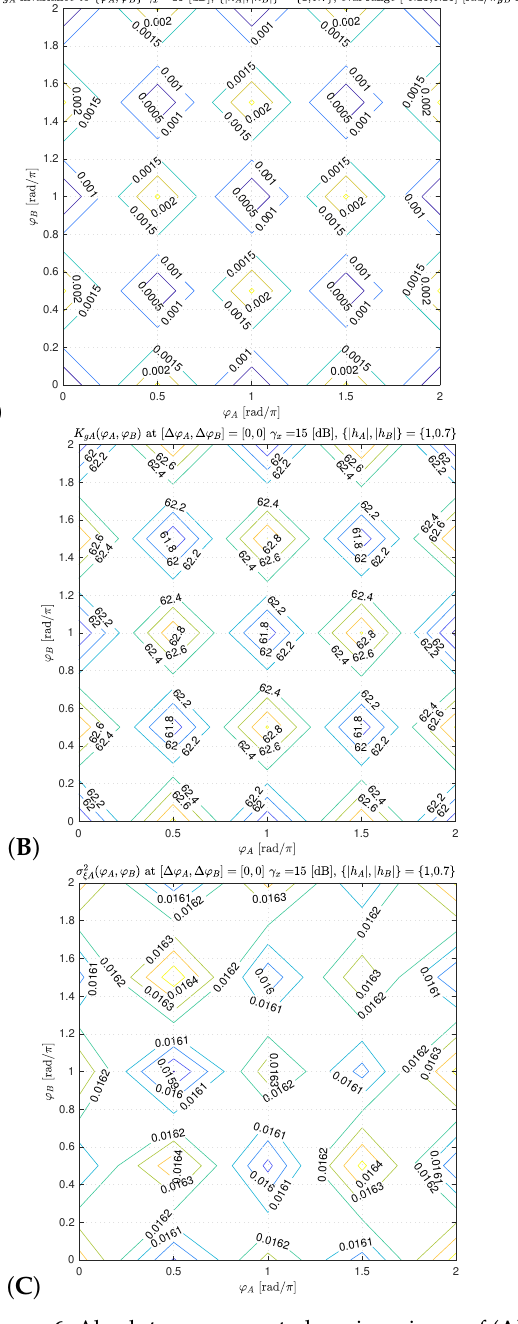
Figure 6. Absolute component phase invariance of ( A ) detector characteristics, ( B ) detector gain and ( C ) equivalent noise variance, γ x = 15